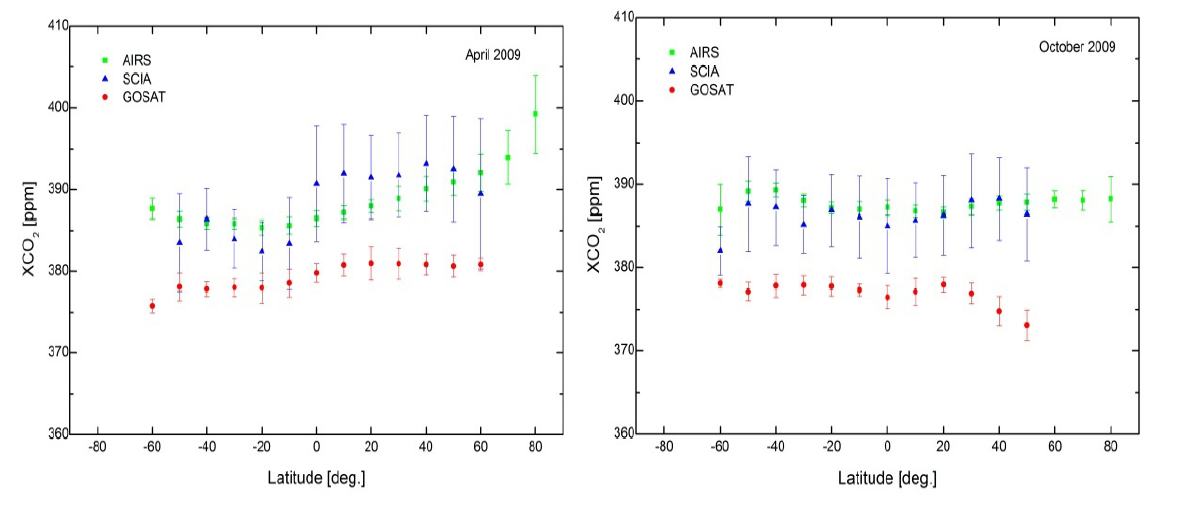
Figure 7. Latitudinal distributions of monthly means of zonal averaged GOSAT (red), SCIAMACHY (blue) and AIRS (green) of XCO October 2009. The vertical bars correspond to the standard deviations of the data within a given